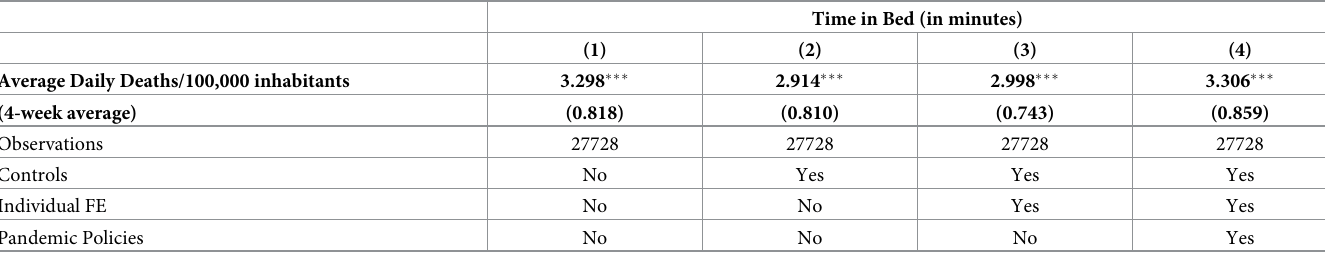
Table 3. Sleep duration and COVID-19 deaths–pooled and panel